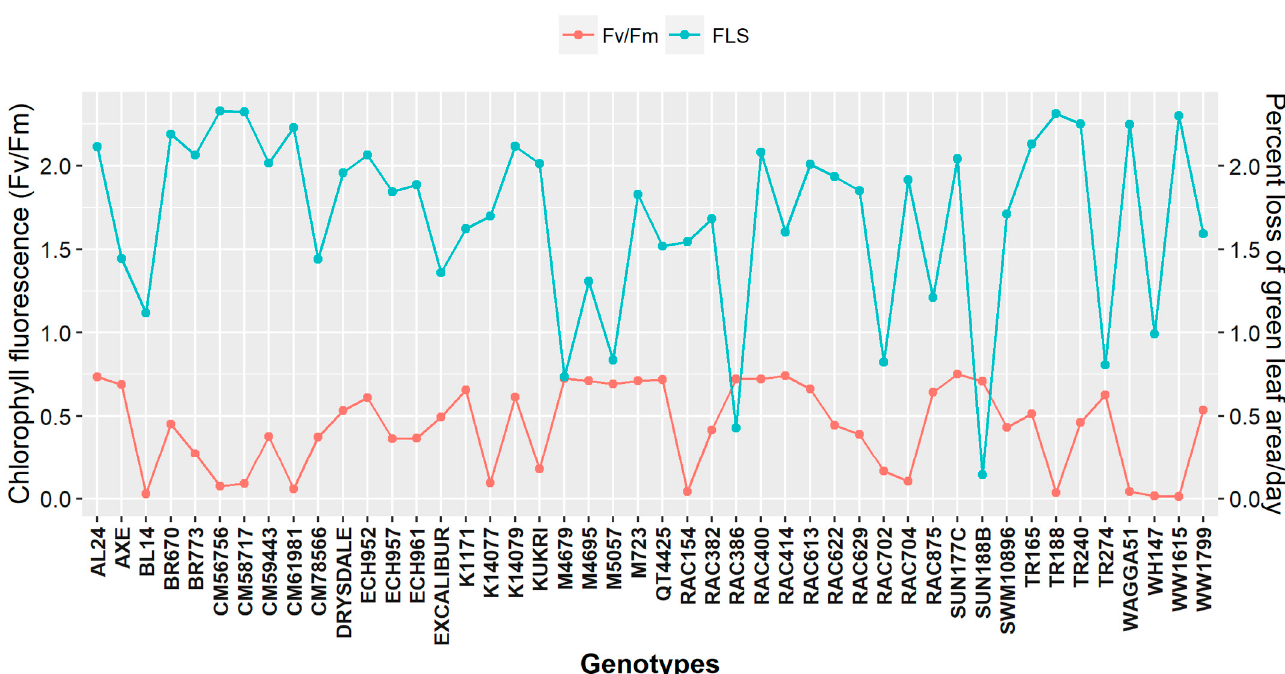
Figure 4. Non-destructive measurement of the relative rate of flag leaf senescence (FLS) as percent loss of the relative green leaf area per day for heat stress and chlorophyll fluorescence (F v /F m ) for drought stress experiment.